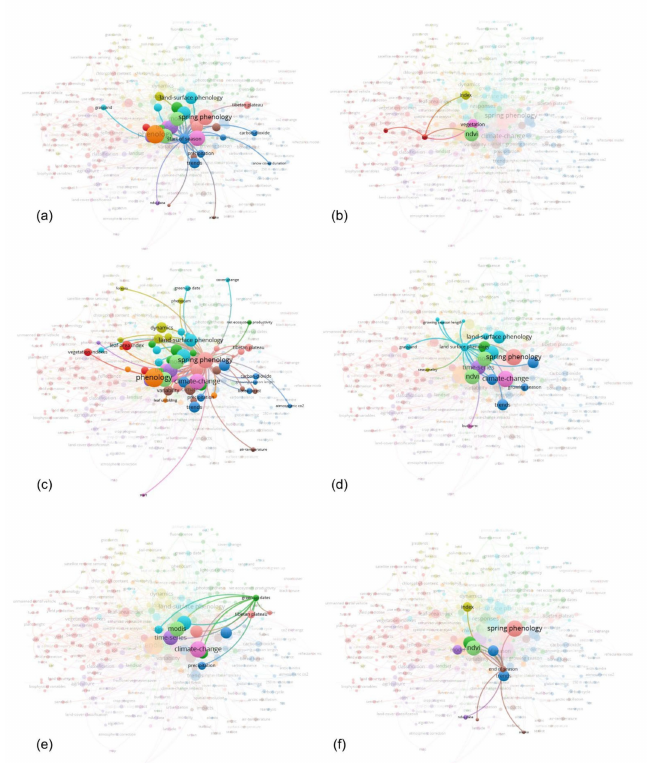
Figure 5. Links between the selected keywords in terms of their strength; ( a ) start of season; ( b ) soil; ( c ) spring phenology; ( d ) land-surface phenology; ( e ) green-up dates; ( f ) end of